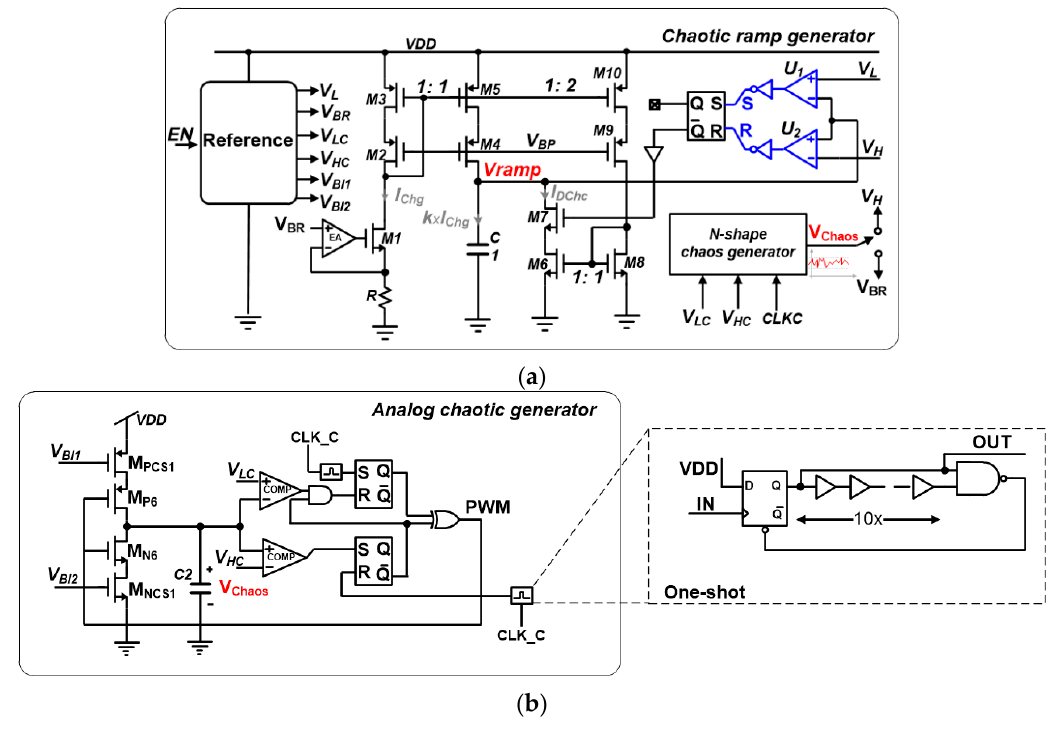
Figure 6. Proposed design of chaotic triangular ramp generator: ( a ) Chaotic ramp generator; ( b ) N-shaped chaos generator.